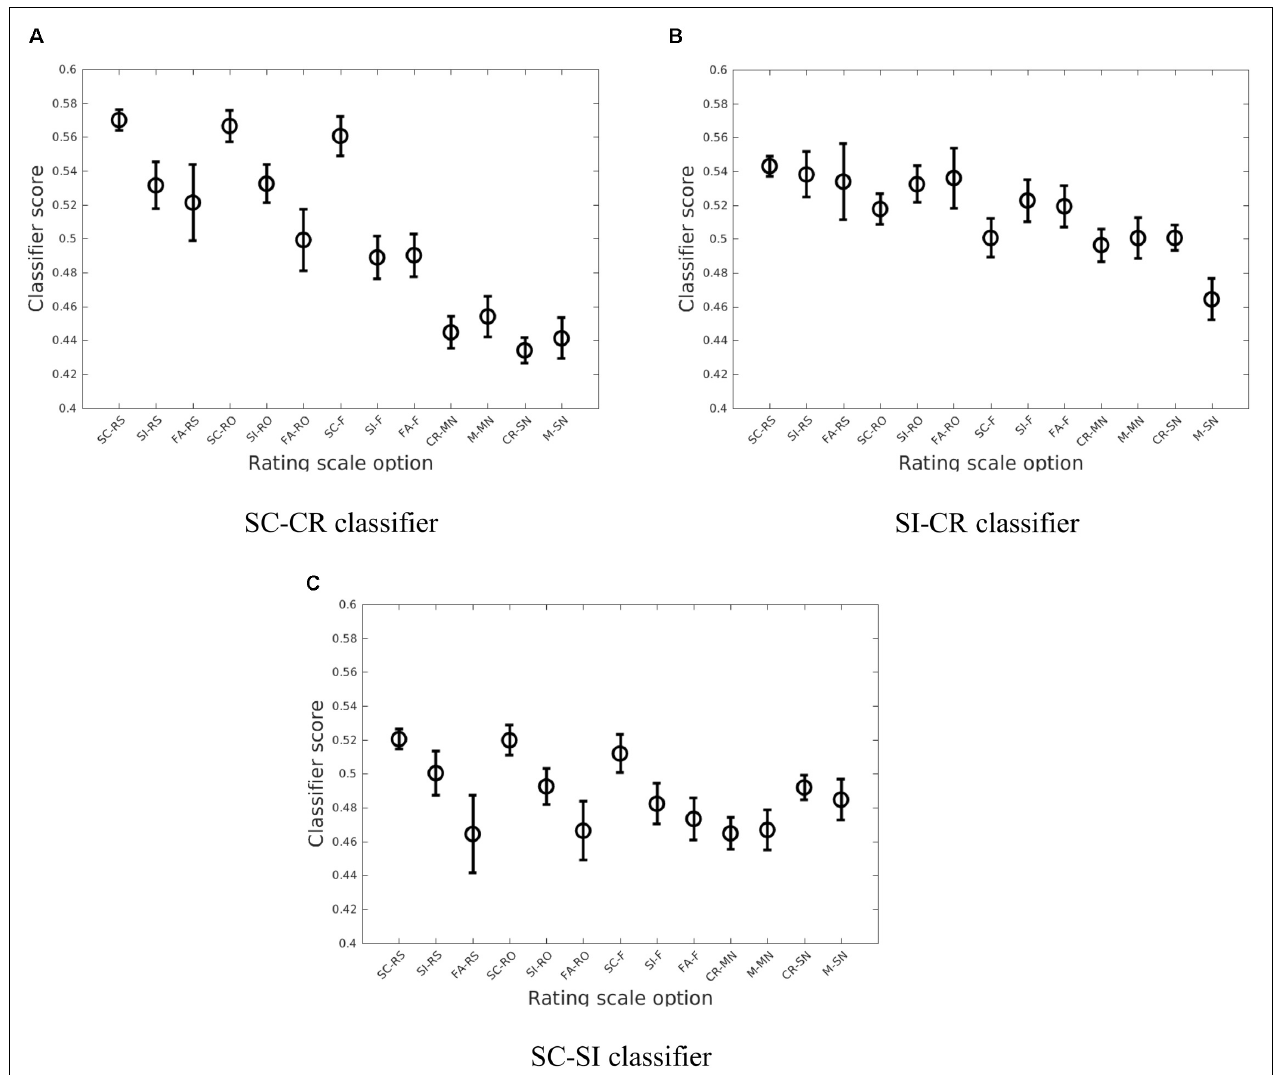
FIGURE 6 | The average of the estimated means and the approximate 95% confidence intervals of the classifier scores (Hochberg and Tamhane, 1987) across the four datasets (Exp 1 (loc), Exp 2 (col), Exp 3-loc, Exp 3-col) when considering the breakdown by subjective ratings (RS, RO, F, MN, and SN) for the three different classification problems ( A : SC vs. CR; B : SI vs. CR; C : SC vs.